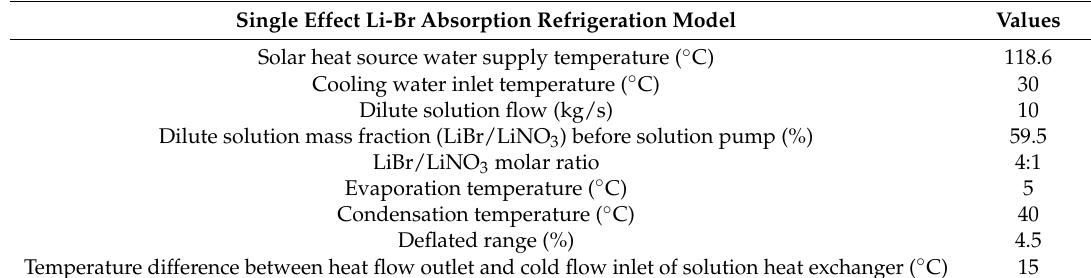
Table 6. Initial specification parameters for simulation